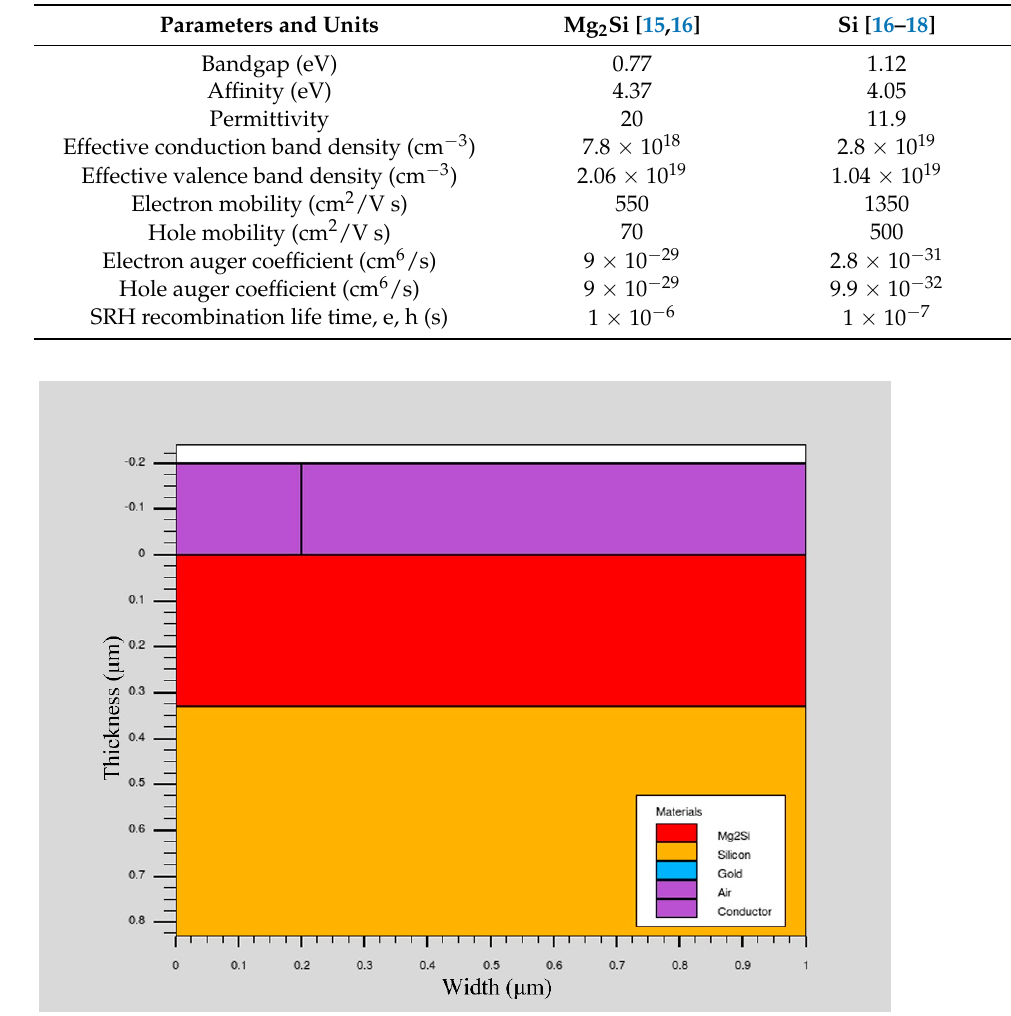
2 SiSi heterojunction